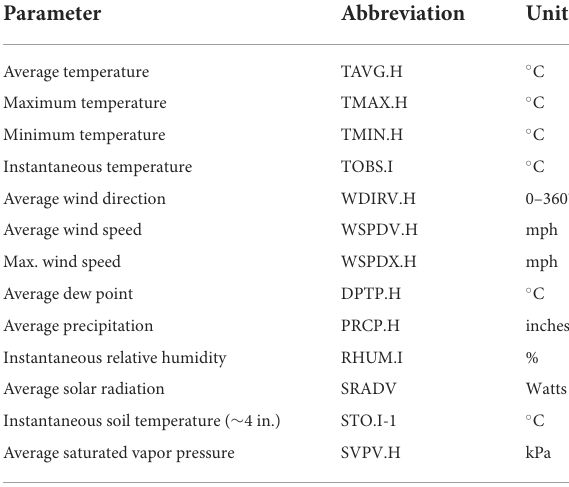
TABLE 1 The variables recorded by the Alcalde weather station and used as features in the machine learning (ML) modeling.